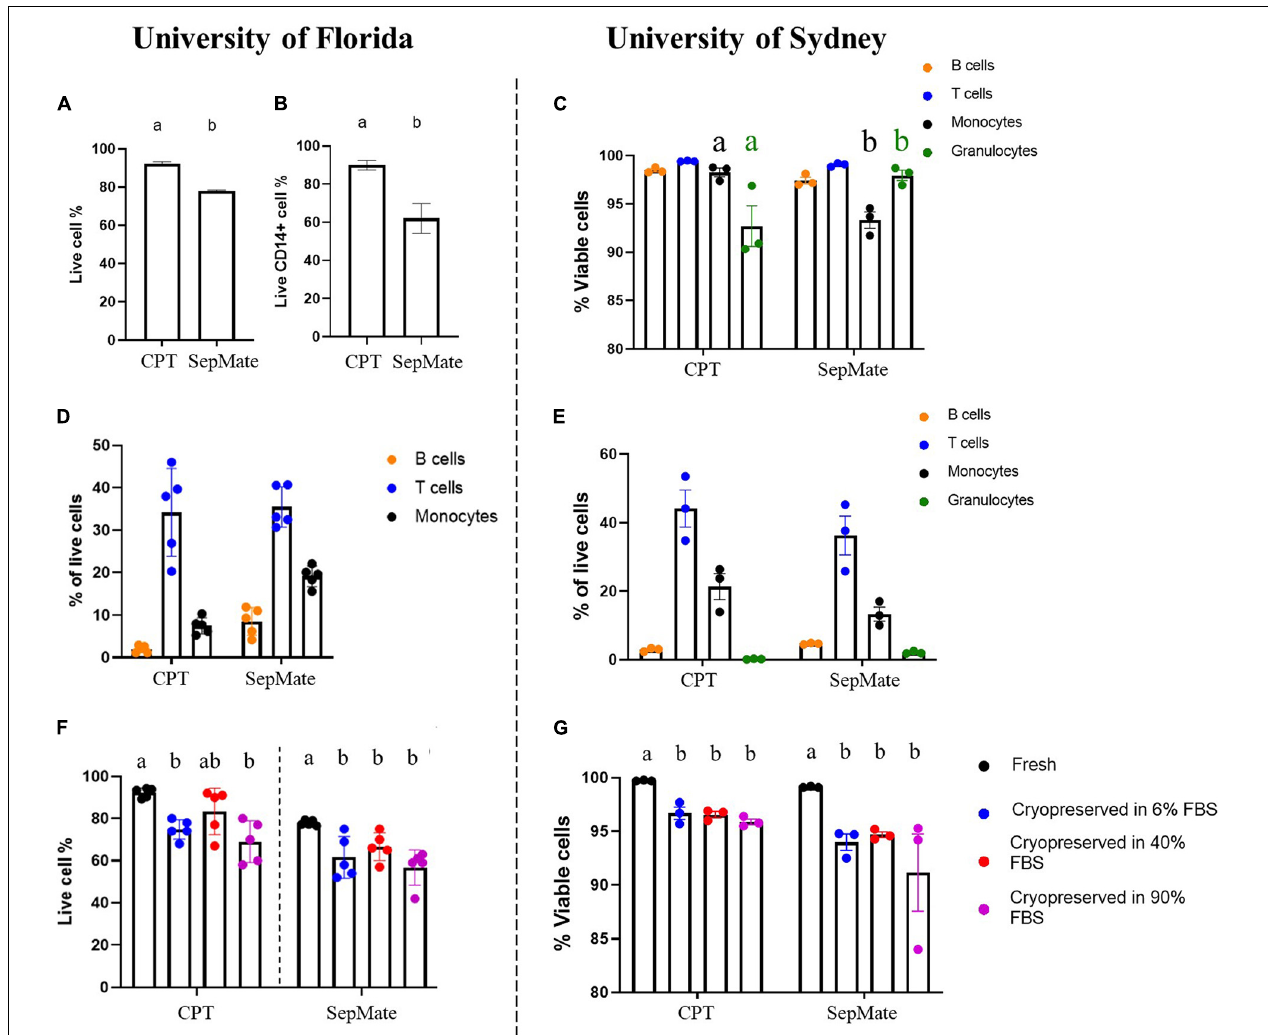
FIGURE 1 | Immune cell viability depends on isolation method but immune cell viability after cryorecovery is site independent. Human PBMCs from healthy volunteers were isolated using CPT or SepMate tubes and assessed for live cell% via flow cytometry (A) and live CD14 + cell% (B) . Immune cell subsets were assessed for viability via flow cytometry (C) . Immune cell subsets were assessed via flow cytometry as a percentage of total live cells at both the University of Florida (D) and the University of Sydney (E) . Independent t -test, groups sharing the same letters are not significantly different ( p > 0.05). Cell viability was assessed following cryorecovery after cryopreservation in 6, 40, or 90% FBS vs. freshly isolated cells via flow cytometry at both the University of Florida (F) and the University of Sydney (G) . Bars represent mean ± SEM ( N = 5). One-way ANOVA, Bonferroni post-hoc , groups sharing the same letters are not significantly different ( p > 0.05) whilst groups displaying different letters are significantly different ( p <